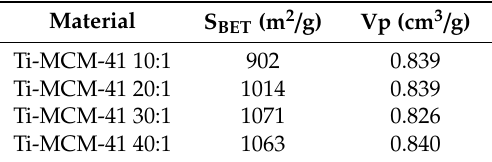
Table 1. Textural parameters for the Ti-MCM-41 catalysts with different molar ratios of Si:Ti in the